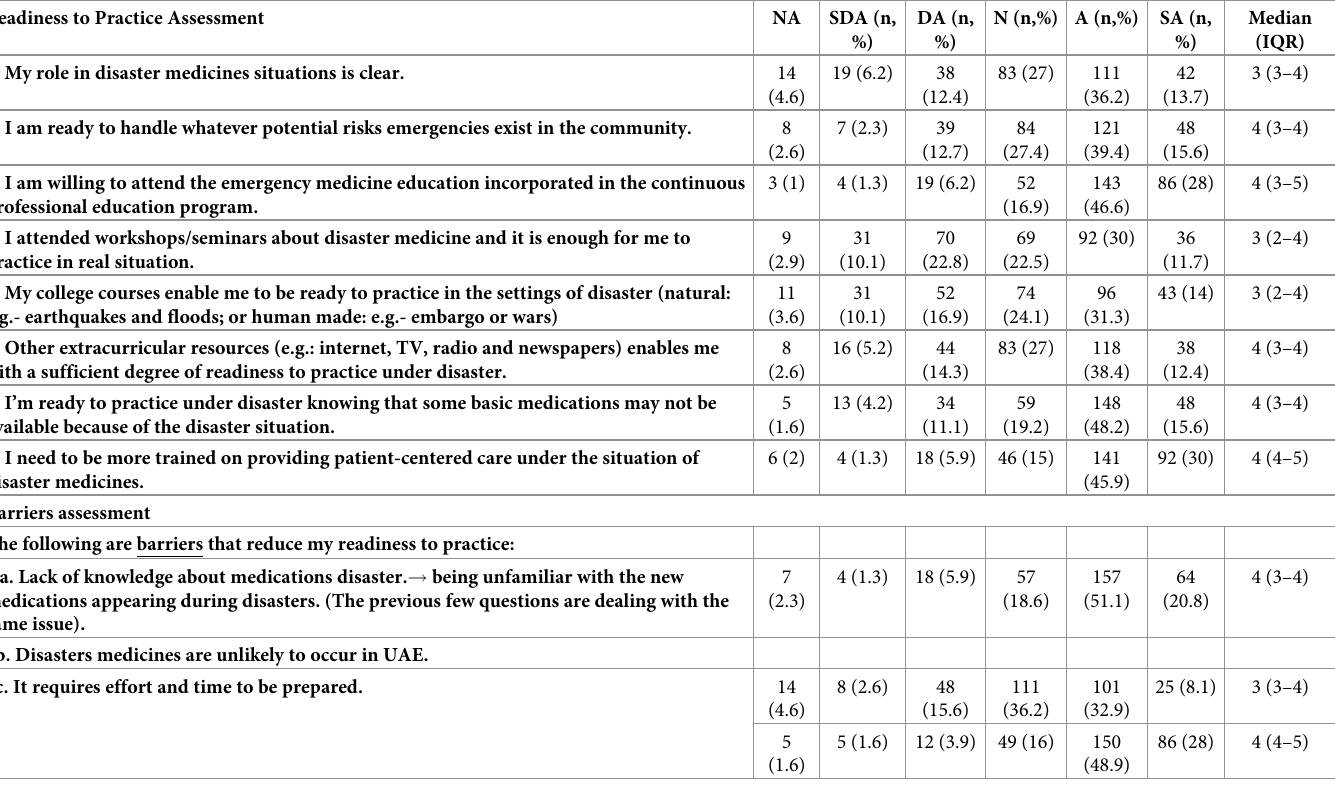
Table 4. Readiness to practice and barriers among HCPs on medicine